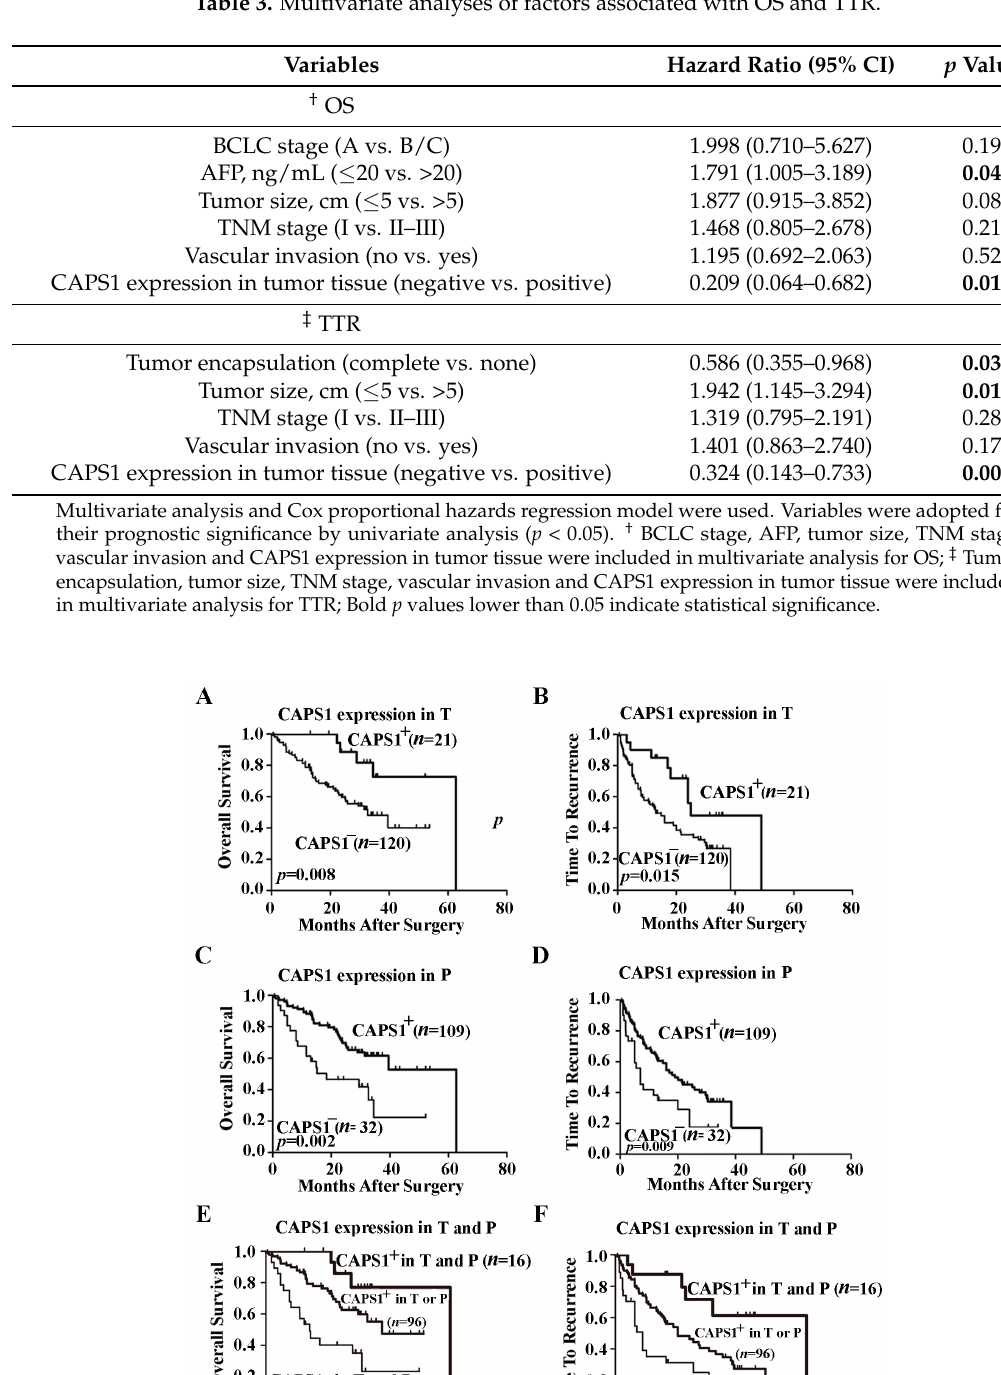
Table 3. Multivariate analyses of factors associated with OS and TTR.